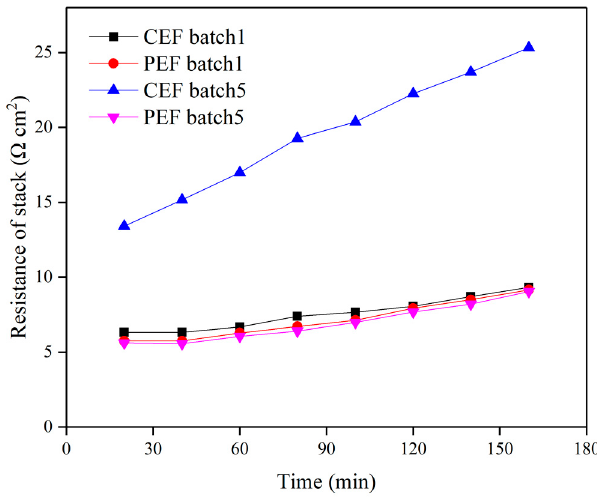
Figure 7. Membrane stack resistance in the demineralization of sodium gluconate mother liquor in batch 1 and batch 5. The conventional direct-current power and the pulse direct-current power operated at constant voltage of 9 V.